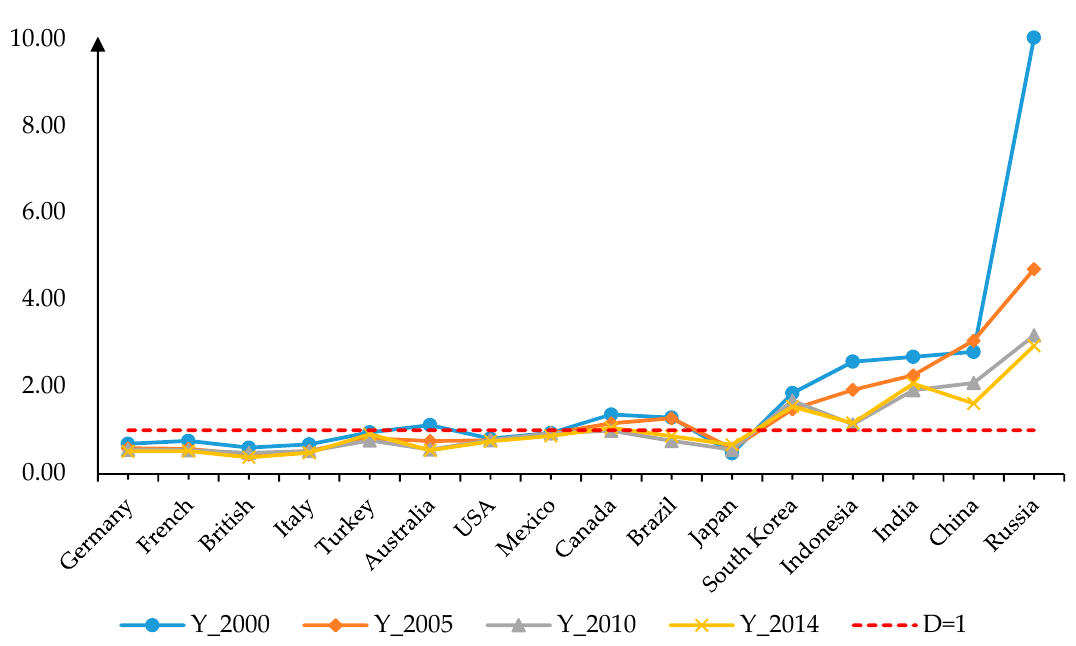
Figure 1. Energy consumption of Group of Twenty (G20) countries from 2000 to 2014.